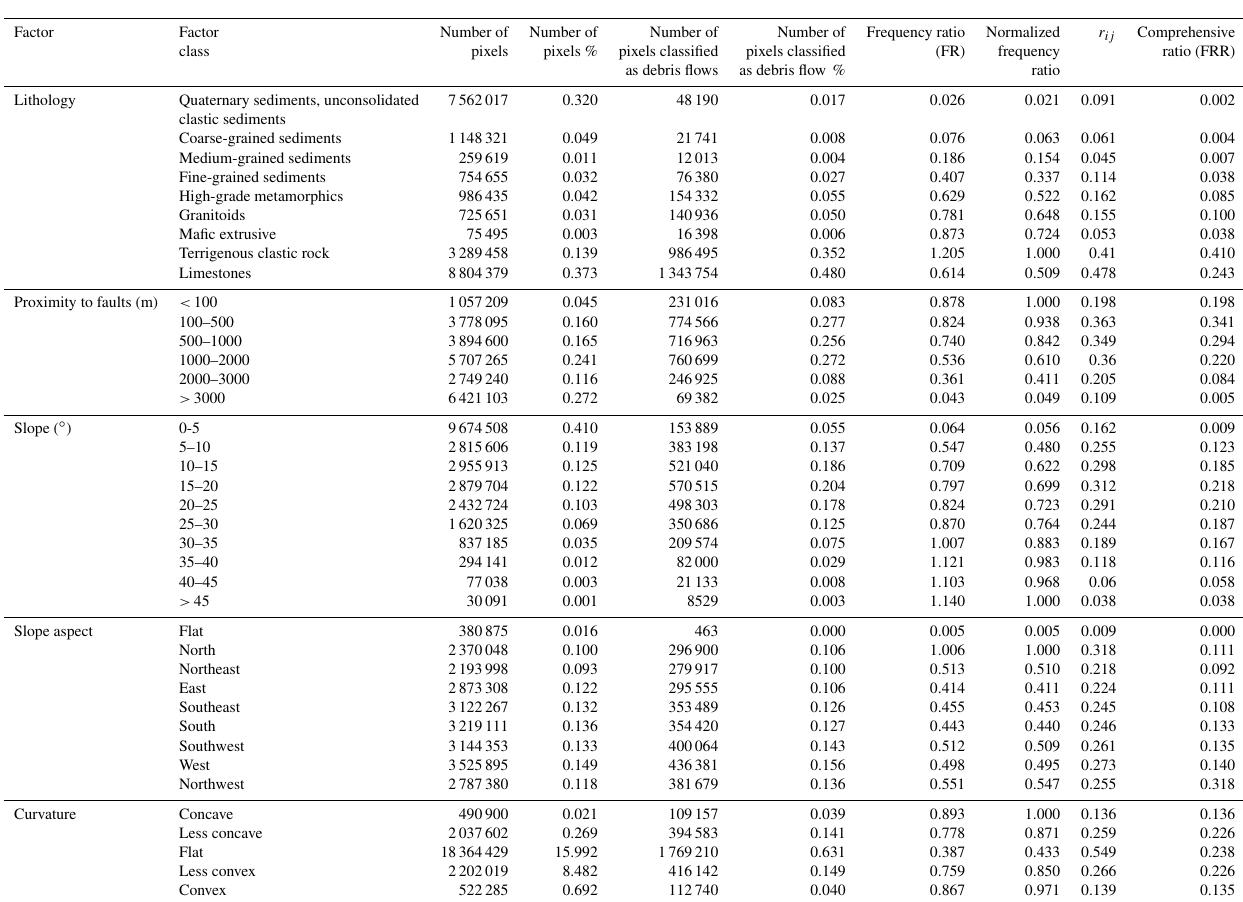
Table 4. Factor categories and their fuzzy membership